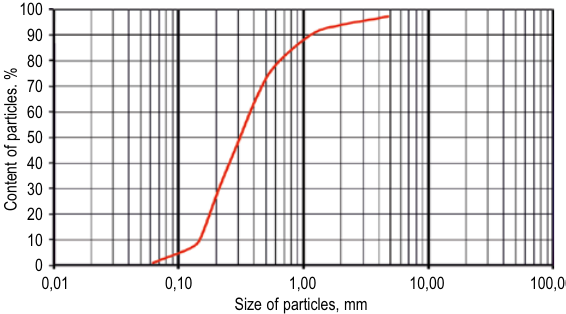
Fig. 2. A curve of the granulometric composition of